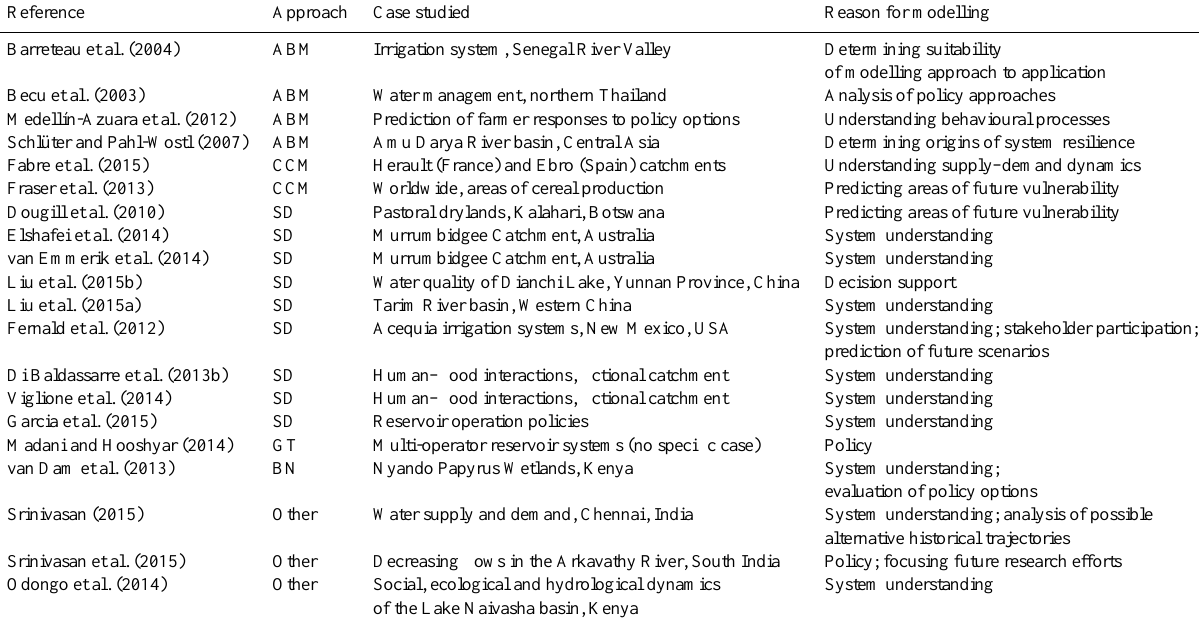
Table 1. Examples of studies that include some aspect of modelling human–water